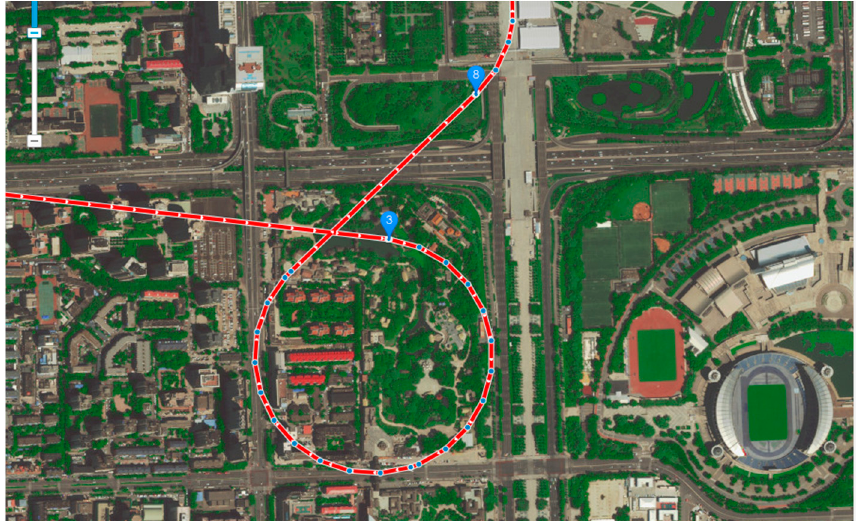
Figure 10. The partial enlarged view of the optimal route of mission points 8 → 3. The red line with arrows is the calculated best route, the marked points represent the mission point.